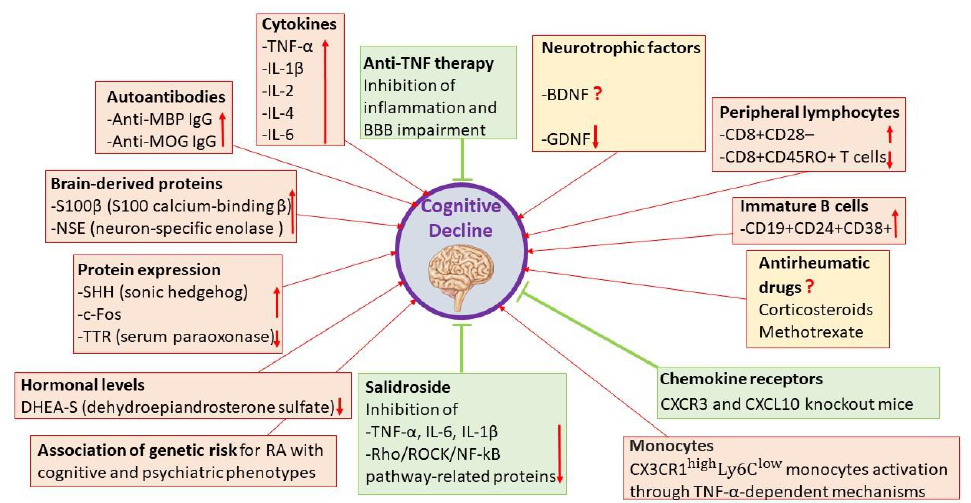
Figure 3. Overview of the possible biological factors involved in the pathogenesis of cognitive decline in rheumatoid ar- thritis.